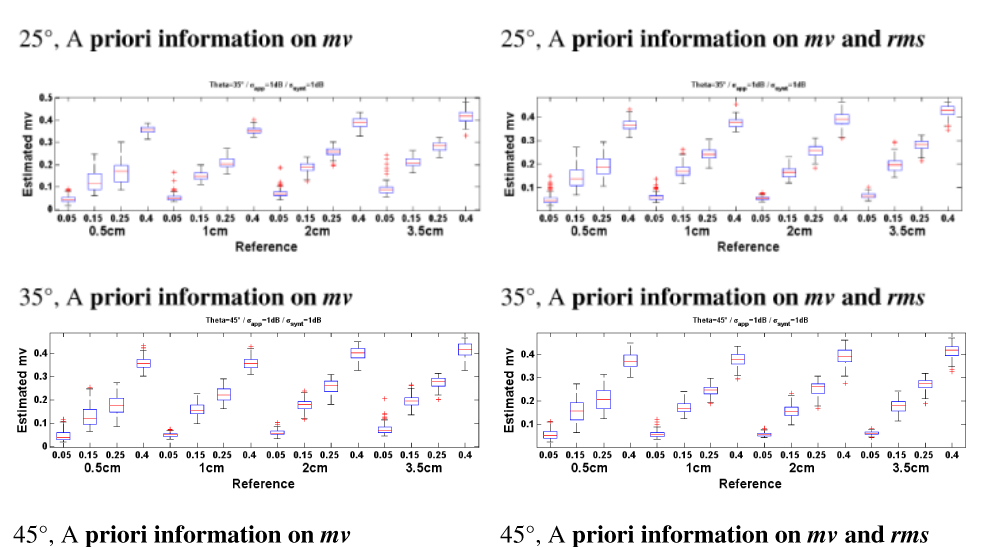
Fig. 2. Box plots of soil moisture estimates (cm 3 cm − 3 ) retrieved from the synthetic dataset. Training and validation datasets correspond to a noise on the backscattering coefficients of ± 1dB. Four rms and four mv values were plotted: rms=0.5, 1, 2, 3.5 cm; mv=0.05, 0.15, 0.25, 0.40cm 3 cm − 3